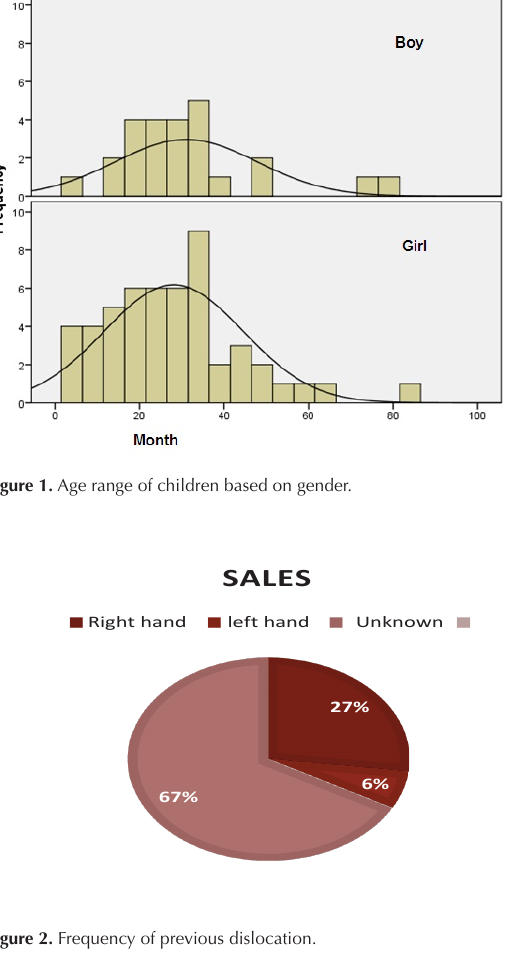
Figure 2. Frequency of previous